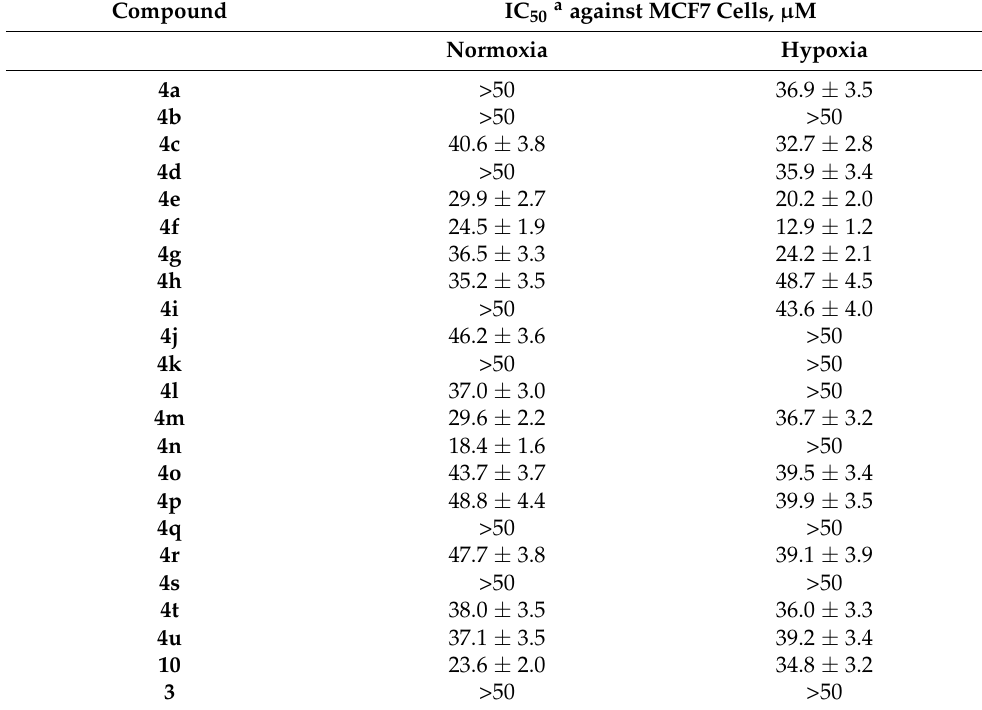
Table 2. Antiproliferative activity of indoline-5-sulfonamides 4a – 4u , 10 (the MTT assay after 72 h exposure; IC 50 , µ M). Compound IC 50 a against MCF7 Cells, µ M